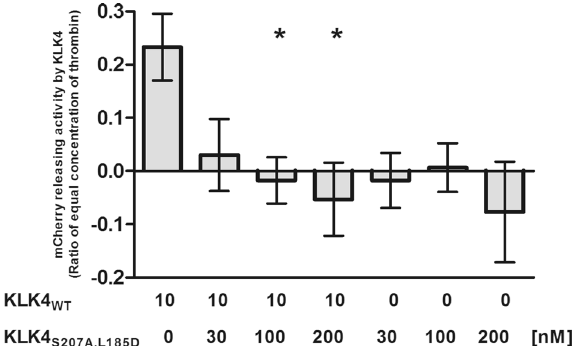
Figure 4. Inhibition by KLK4 S207A,L185D of the ability of KLK4 WT to cleave the N-terminus of PAR1. Fluorescence of mCherry released from the PAR1 N-terminus by KLK4 WT in the absence or presence of increasing concentrations of the substrate-capture KLK4 S207A,L185D mutant of KLK4 was detected in supernatant of mCherry-PAR1-YFP transfected WM3682 indicator cells, as outlined in Methods. The release of the N-terminal mCherry tag of PAR1 by wild-type KLK4 (1 U/mL) was expressed as a ratio of the release caused by 1 U/mL/10 nM thrombin in the same experiment. The KLK4-mediated cleavage-release of the PAR1 N-terminus was blocked by KLK4 S207A,L185D , which alone did not release the N-terminus (right-hand histograms). Data showing the mCherry release caused by KLK4 relative to that caused by 1 U/mL thrombin represent the average fluorescence release ± SEM for 4 replicate monolayer samples. *, P < 0.05 by one-way ANOVA for the release in the presence, vs the absence, of KLK4 S207A,L185D